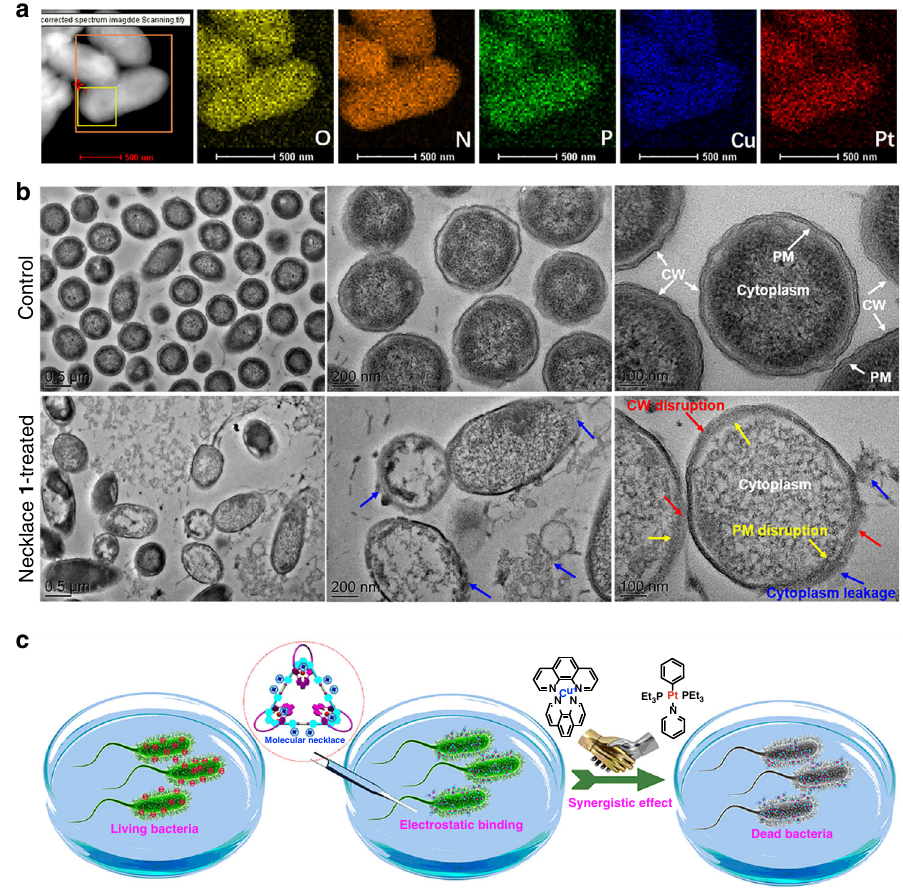
Fig. 6 Contribution of bacterial binding and cell wall/plasma membrane disruption to bactericidal activity of necklace 1. a EDS mapping of the main elements (i.e., O, N, P, Cu, and Pt) on the bacterial cell surface (scale bar = 500 nm). b TEM observation of ultrathin sections of the control and necklace 1- treated cells (after 30 min of treatment). i and iv Scale bar = 500 nm. ii and v Scale bar = 200 nm. iii and vi Scale bar = 100 nm. The red, yellow, and blue arrows indicate cell wall (CW) disruption, plasma membrane (PM) disruption, and cytoplasm leakage, respectively. Ultrathin sections were cut with a diamond knife, collected on 200-mesh copper grids, stained with uranyl acetate and lead citrate, and examined with a JEM-2100 transmission electron microscope. c Schematic diagram of the bacterial binding and synergetic bactericidal mechanism of molecular necklace 1